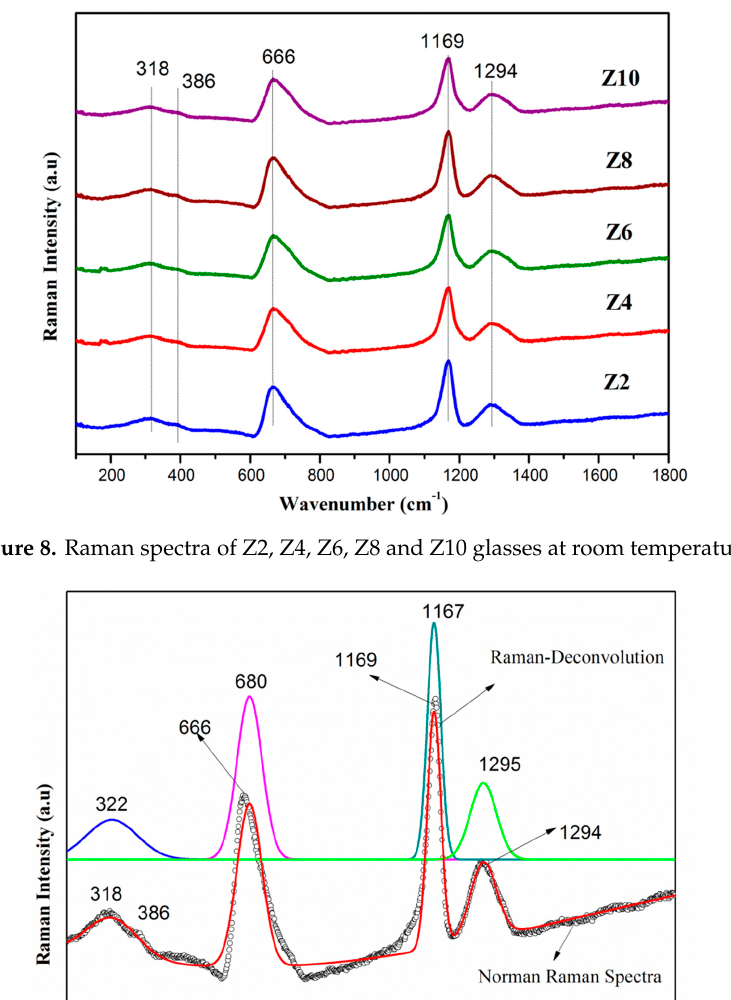
Figure 7. Deconvoluted FTIR spectra of the glass (Z2) and curve fit.